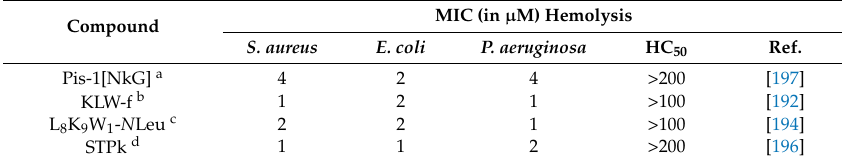
Table 4. Antimicrobial activity of representative AMPs containing peptoid